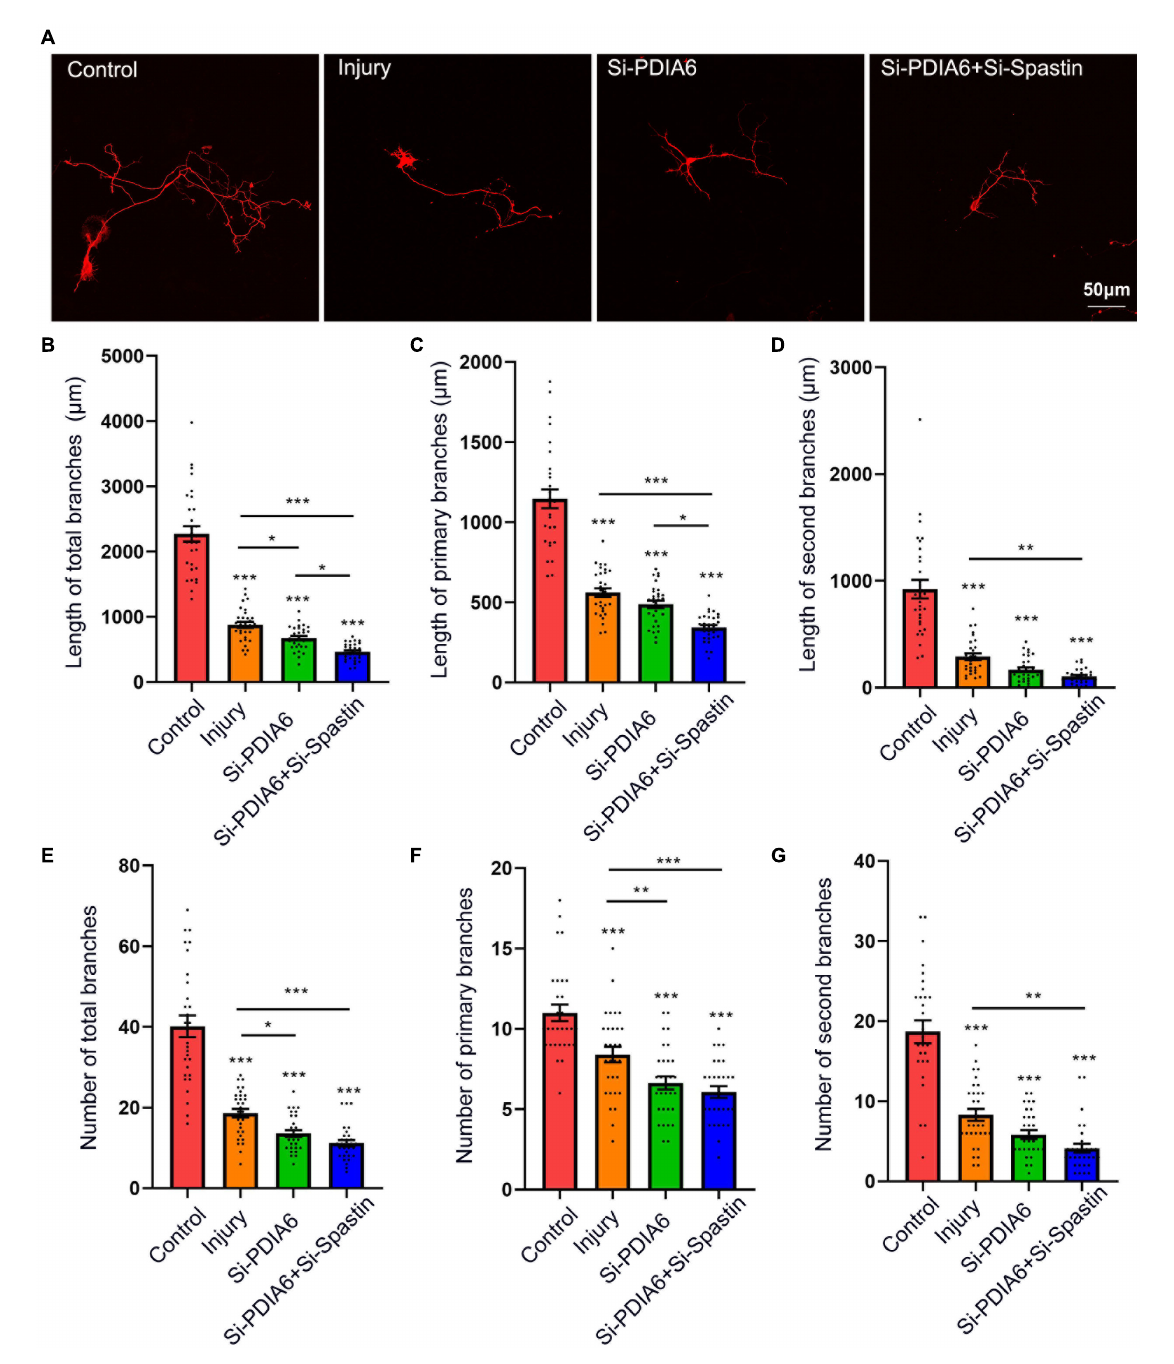
FIGURE6 The knockdown of PDIA6 and spastin inhibits injured neuron repair. (A) Following culture in vitro for 3 days, glutamate (120 µ M) was used to injure hippocampal neurons. At 12 h post-injury, neurons were co-transfected for 24 h with Flag/NC, Si-PDIA6, or Si-PDIA6/Si-Spastin. Scale bar: 50 µ m. (B–D) Total (B) , primary (C) , and secondary (D) branch lengths were measured, indicating that PDIA6 knockdown suppressed branch repair in these injured neurons, while the knockdown of both PDIA6 and spastin suppressed injured neuronal repair ( n = 30/group). (E–G) Total (E) , primary (F) , and secondary (G) branch numbers, indicating that PDIA6 knockdown suppressed branch formation by injured neurons, and that PIDA6 and spastin knockdown similarly inhibited branch formation ( n = 30/group). * P < 0.05, ** P < 0.01, *** P <